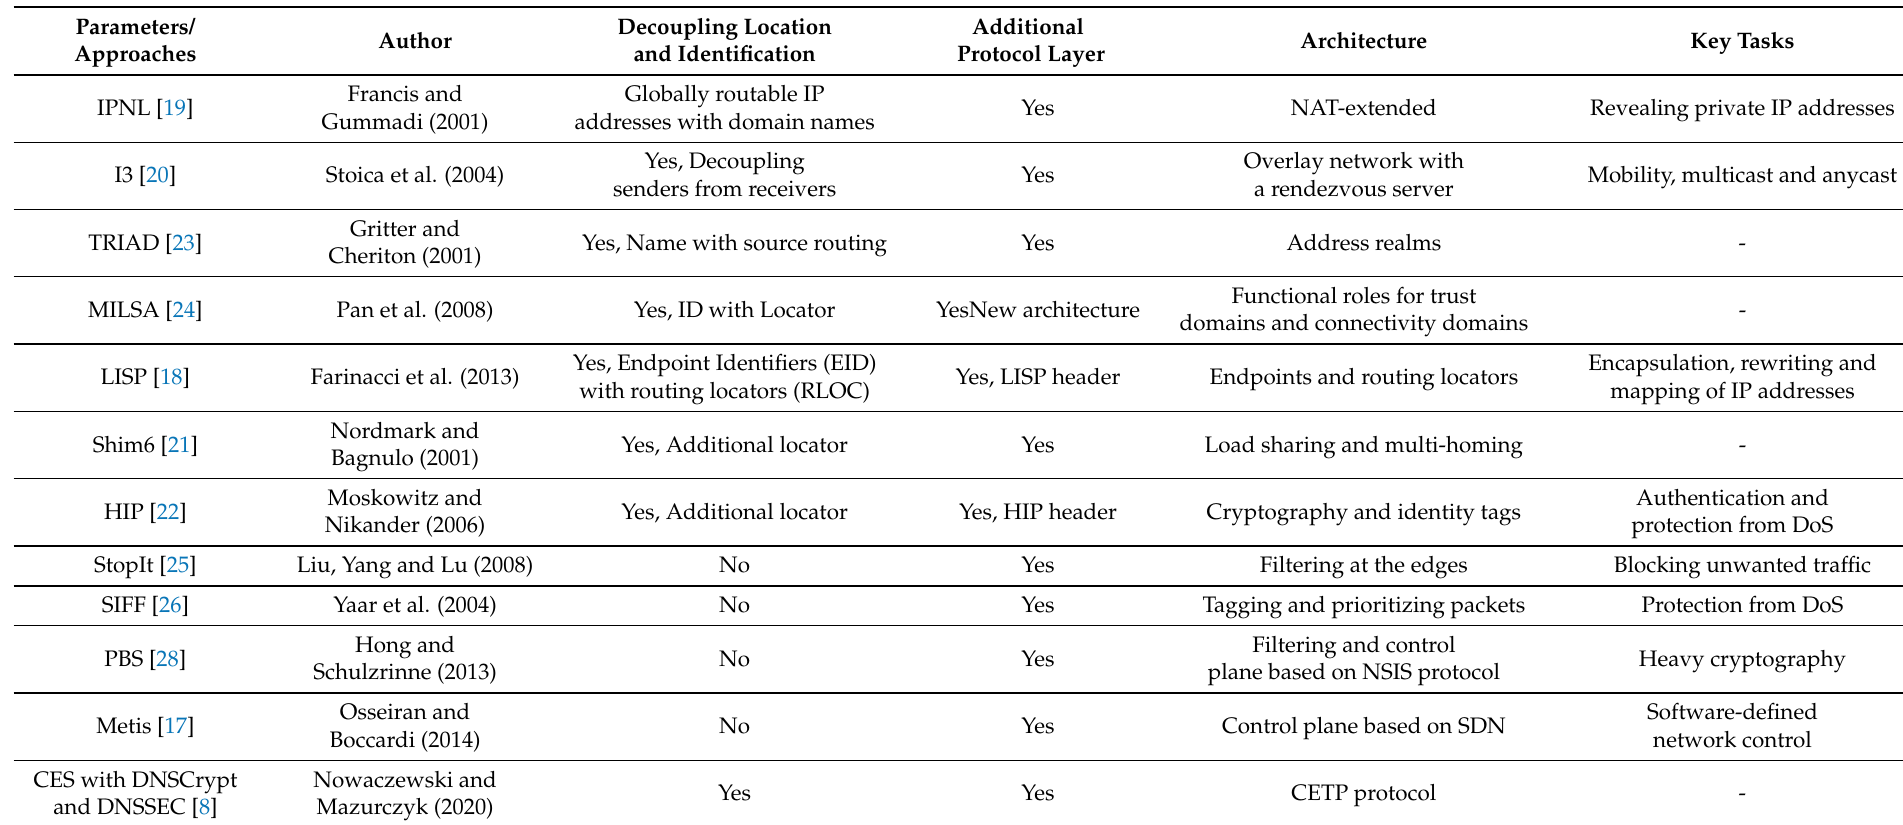
Table 1. State-of-the-art comparison between the approach and key solutions for the different network architectures